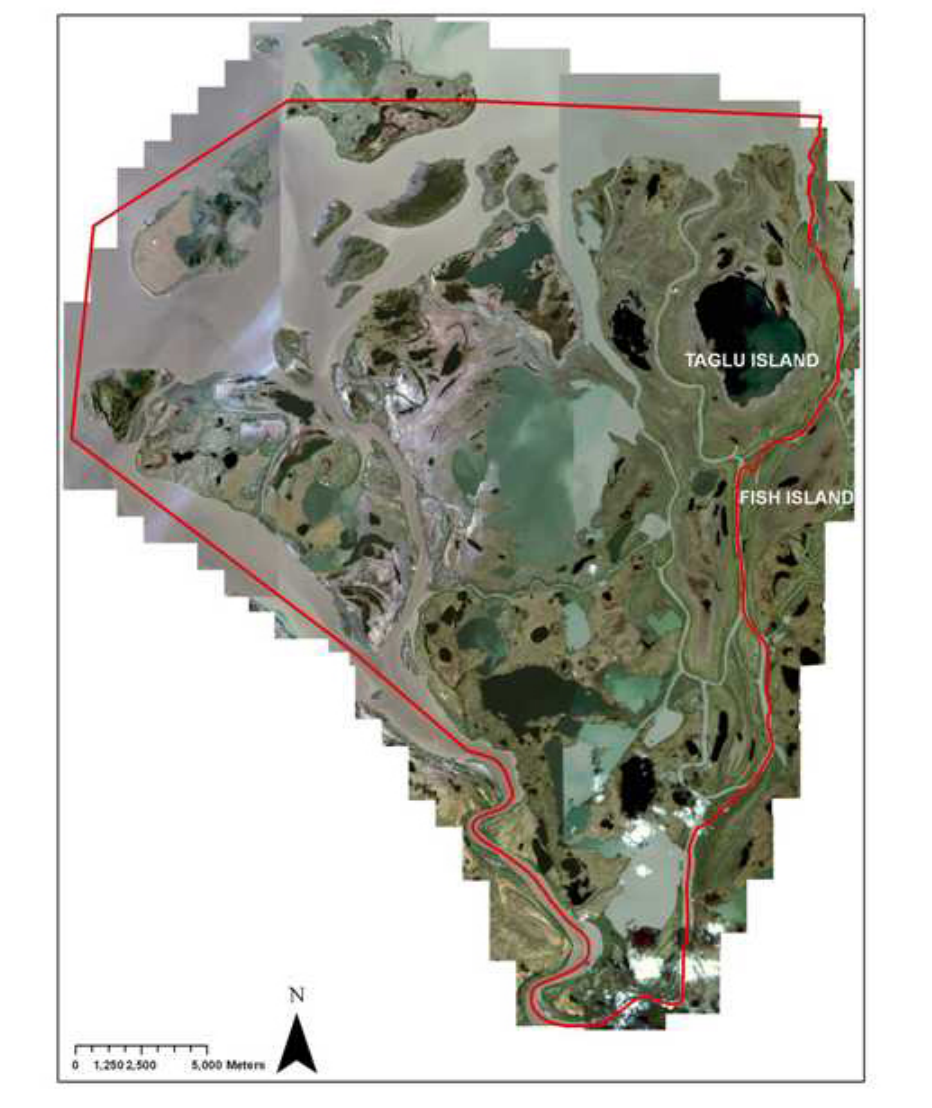
Fig. 2. A false-color satellite image of Taglu and Fish Islands (labeled) in the Kendall Island Bird Sanctuary, outer Mackenzie Delta, Northwest Territories. The red outline indicates the boundaries of the